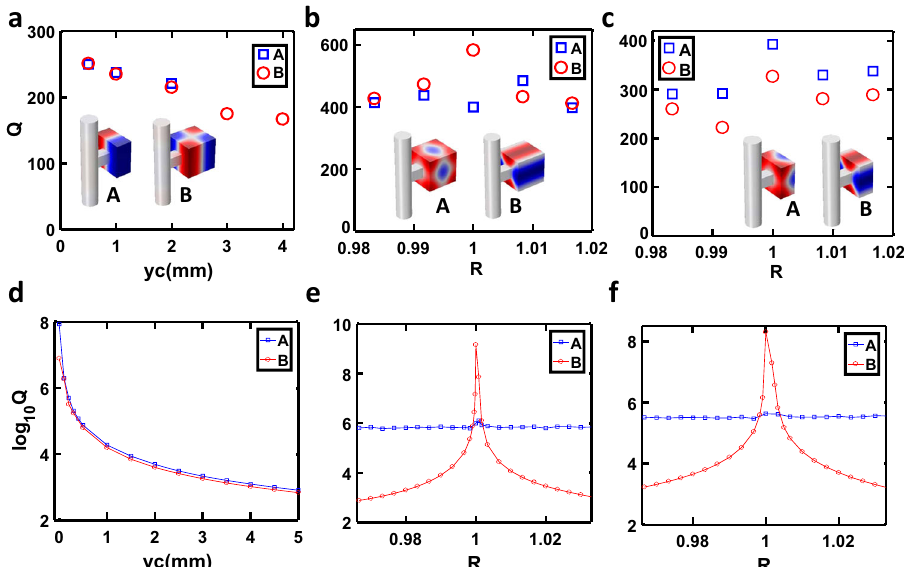
Q -factor of modes A (M 131 ) and B (M 113 ) for half resonator